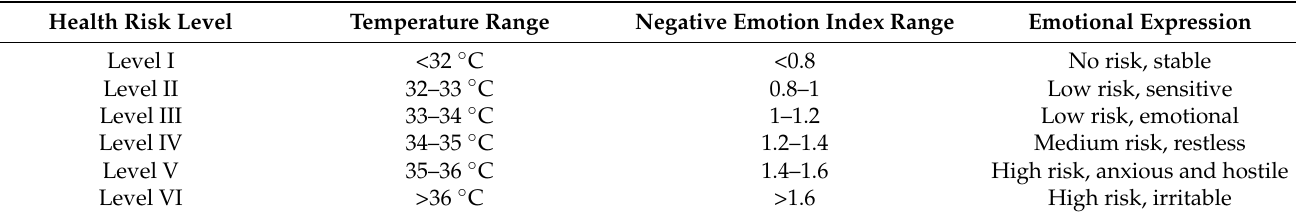
Table 2. Assessment standard of high temperatures’ emotional health risk.